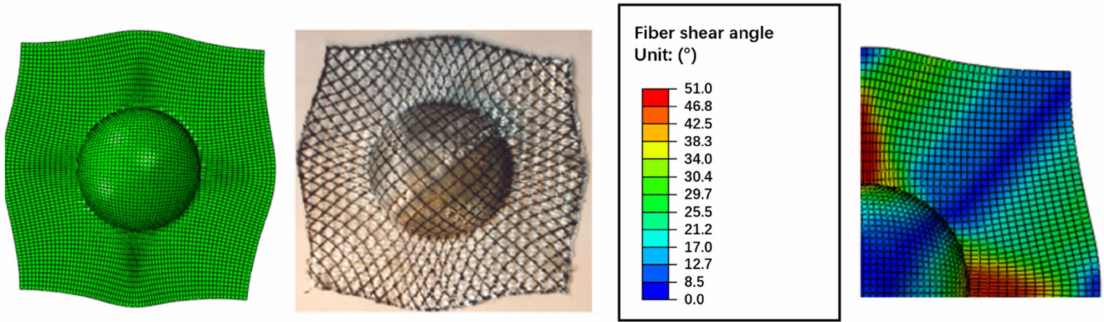
Figure 12. Deformation of the CFRTP composites with -45/45 degree fiber